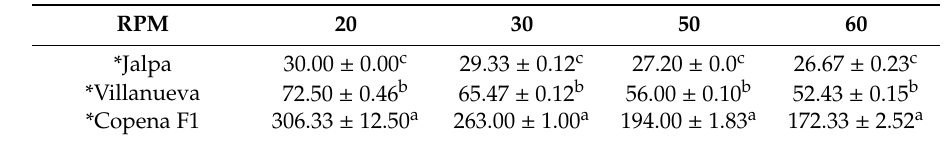
Table 2. Viscosity (mPa × s) of formulations based on the mucilage of three cultivars of Opuntia ficus- indica ; revolutions per minute (RPM) from 20 to 60.